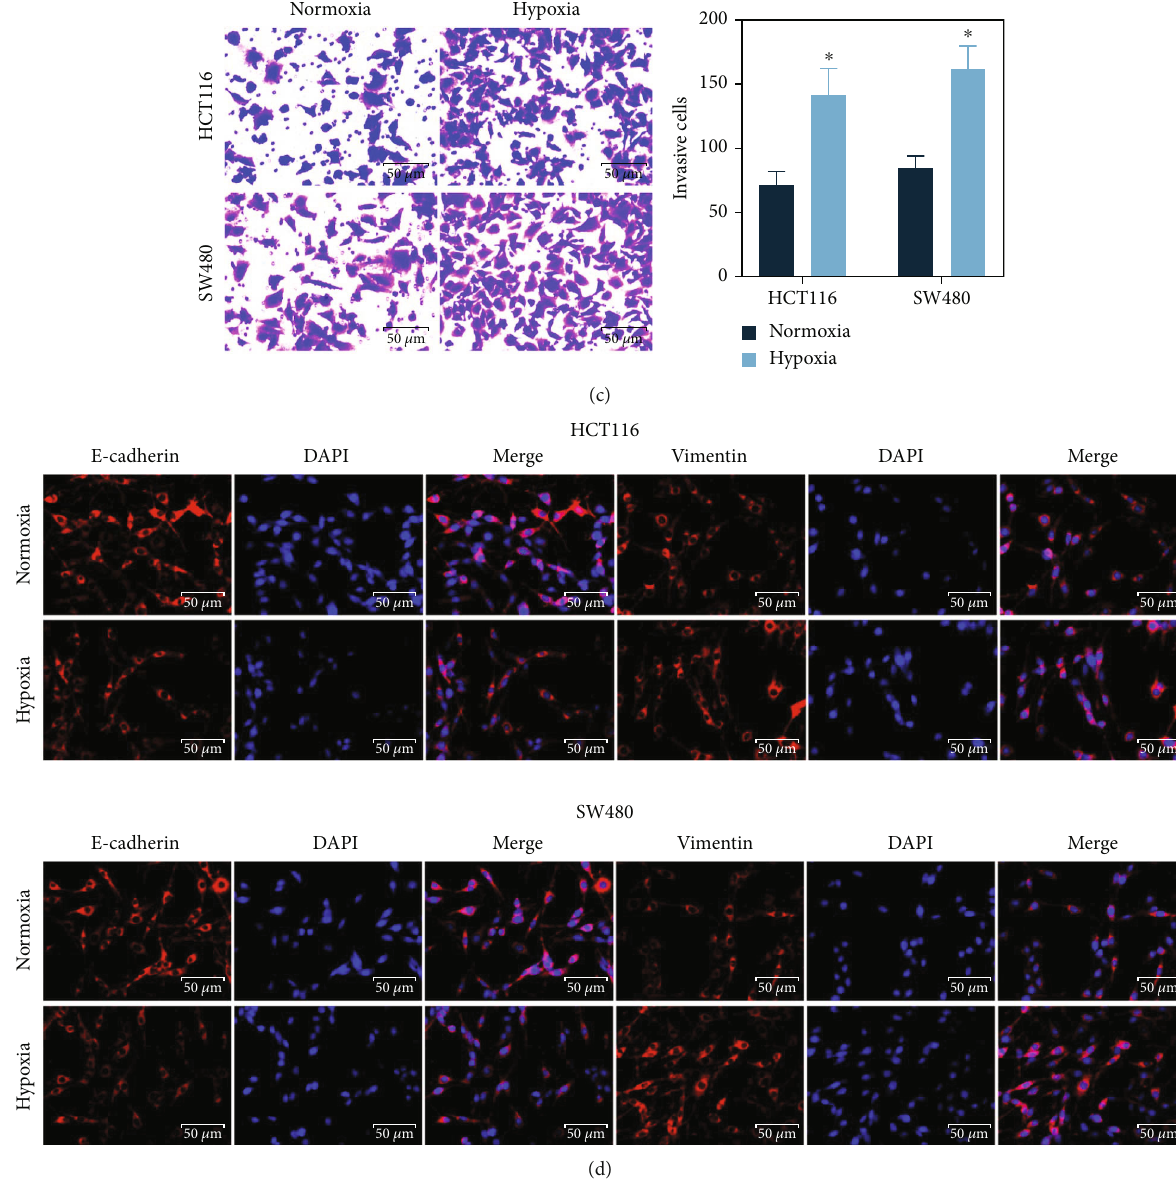
Figure 1: Hypoxia stimulates activity of the CRC cells: (a) viability of HCT116 and SW480 cells evaluated using the CCK-8 assay ( ∗ p < 0 : 05 , two-way ANOVA); (b, c) migratory (b) and invasive (c) activities of CRC cells examined by Transwell assays ( ∗ p < 0 : 05 , two-way ANOVA); (d) expression of EMT markers Vimentin and E-cadherin in cells determined by immuno fl uorescence staining. Data were presented as the mean ± SD from three independent